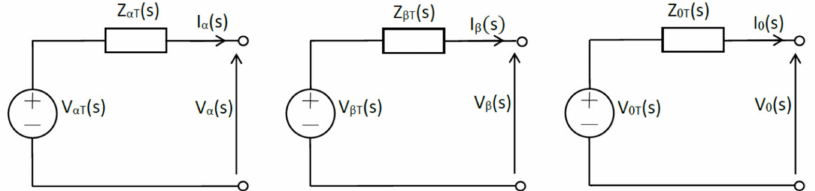
Figure 4. Laplace-domain Thevenin equivalents of the three modal circuits α , β , 0, according to the Clarke